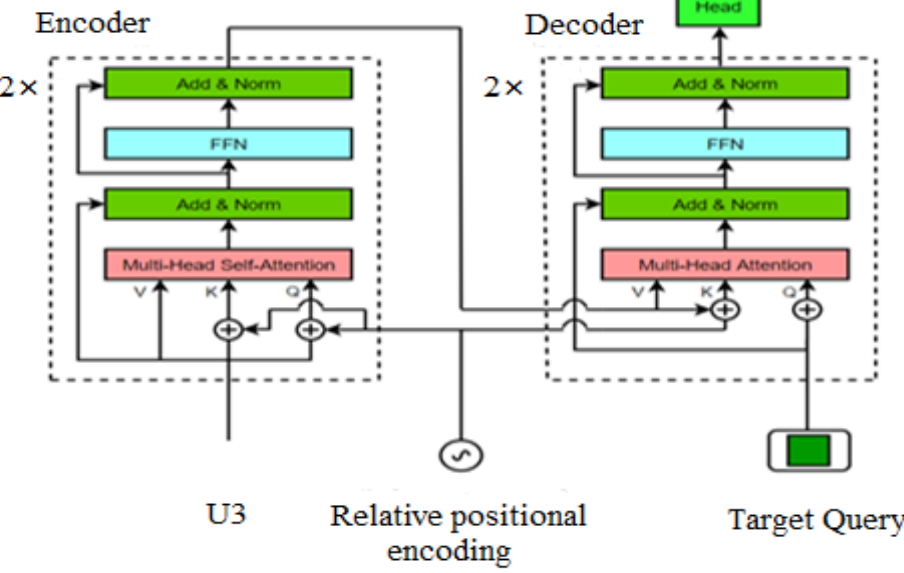
Figure 6. The structure of feature fusion network.